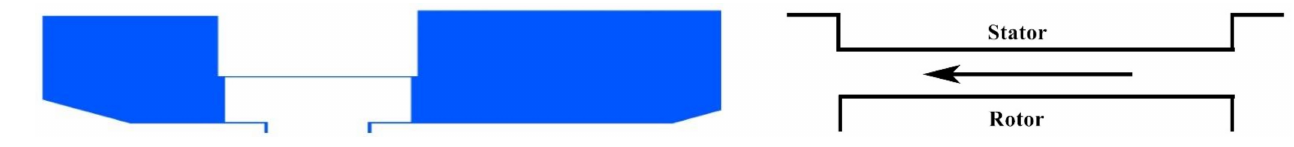
Figure 3. The schematic model of the stator–rotor